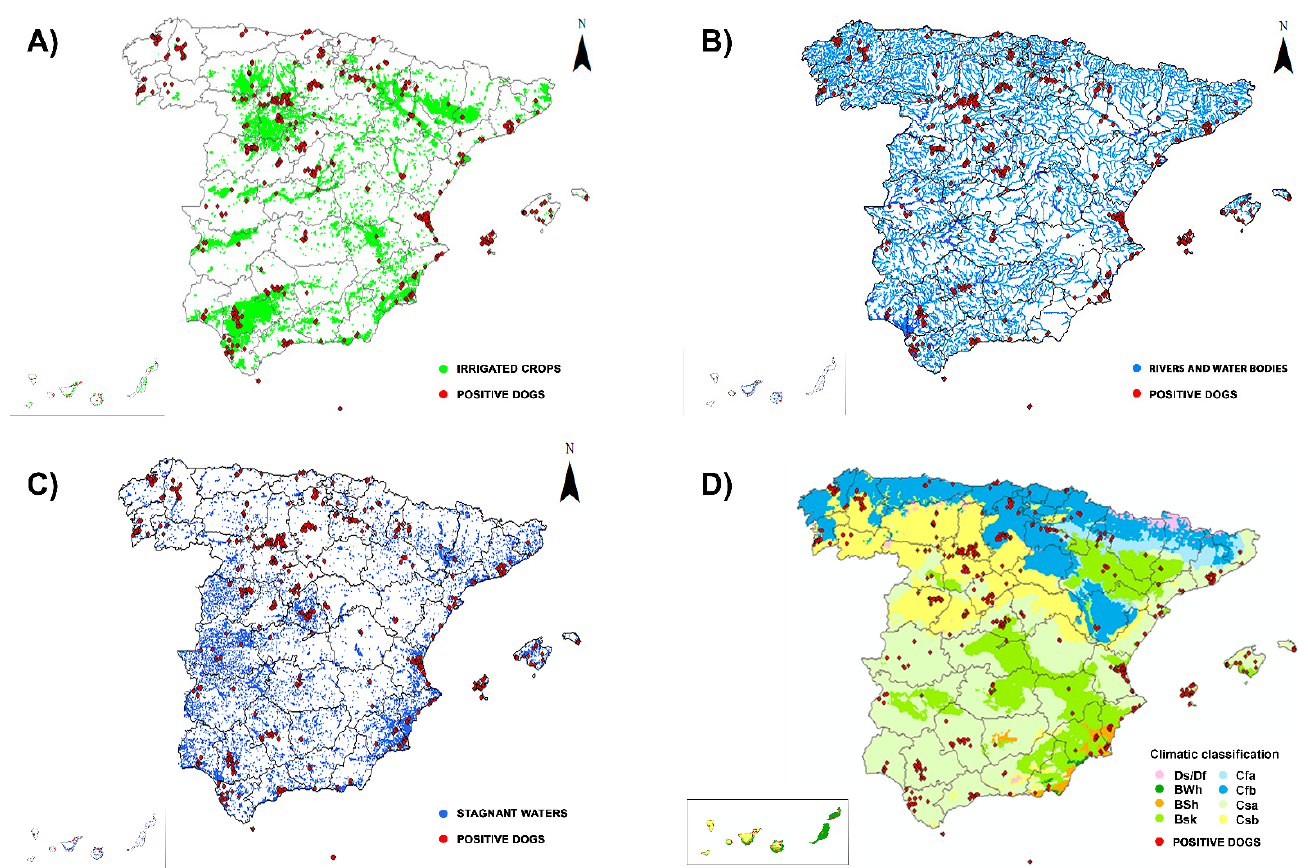
Figure 3. Location of irrigated groups ( A ), rivers and water bodies ( B ), artificial and natural stagnant waters ( C ) and climates (Köppen Climate Classification System) ( D ) in Spain and geolocation of the dogs infected by Dirofilaria immitis .